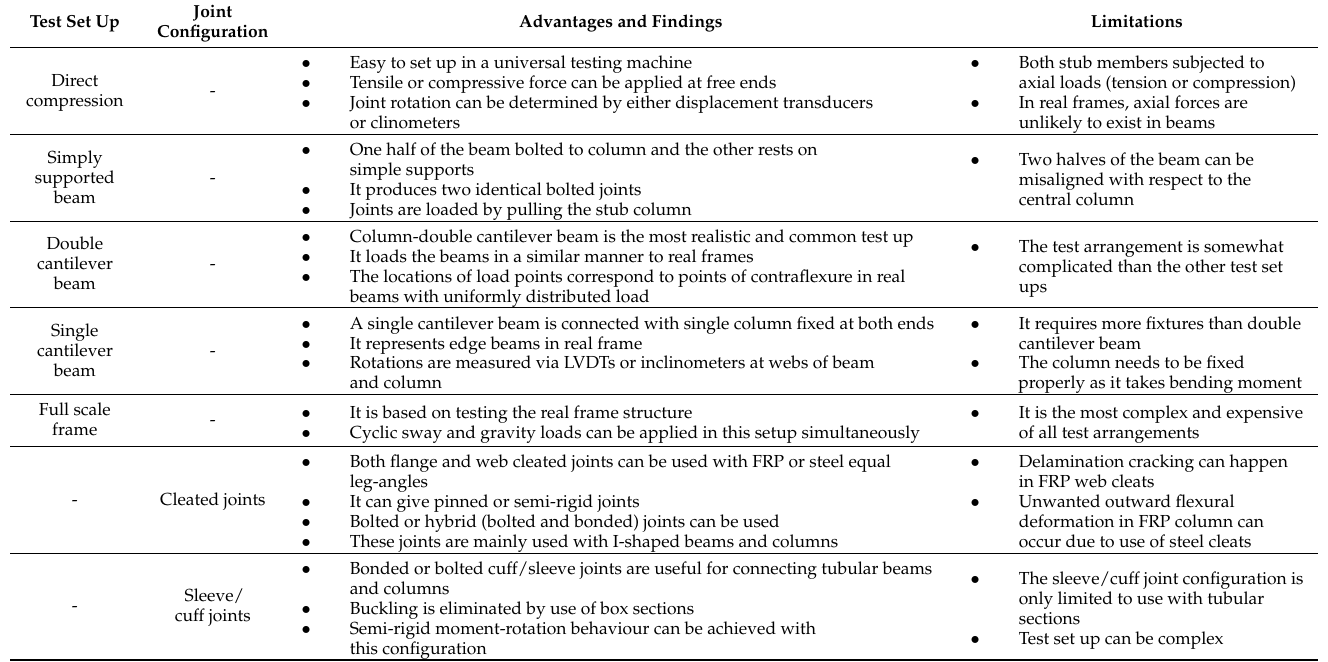
Table 8. Advantages and limitations of different test set ups and joint